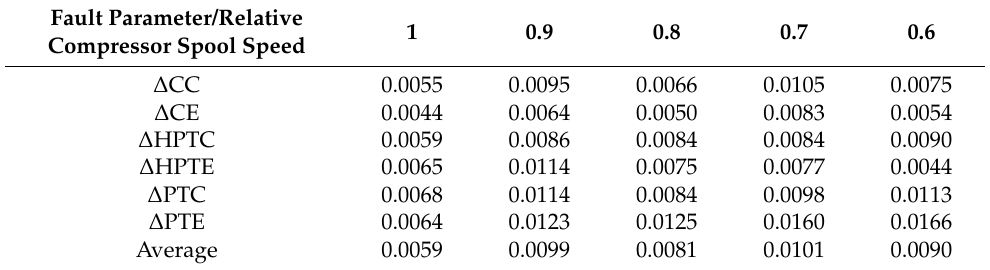
Table 4. RMSE for 5 operating regimes.